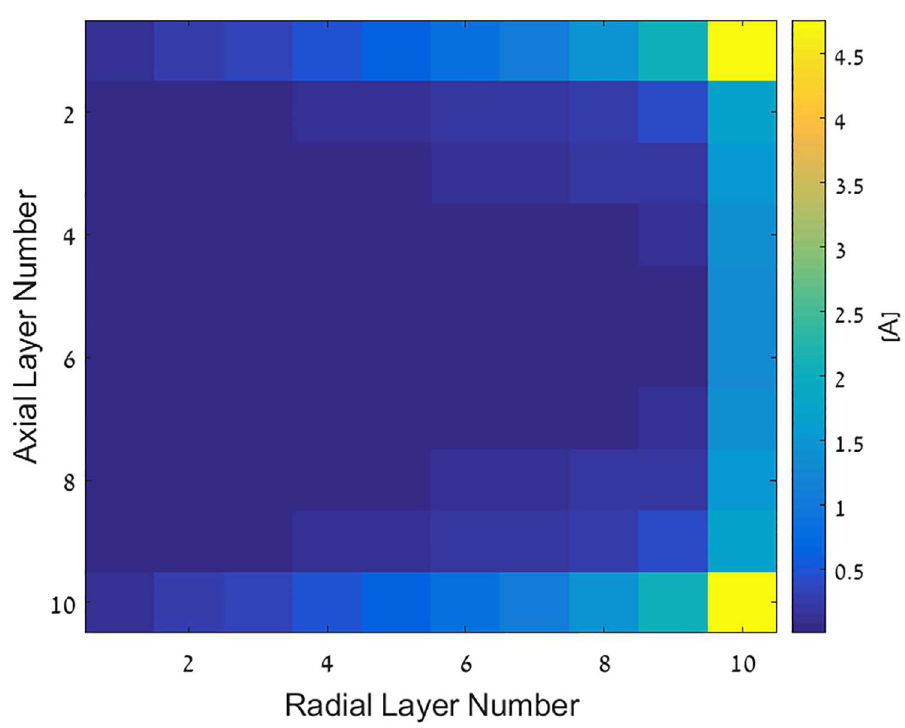
Fig 3. Current distribution in optimal multi-layer solenoid coil.